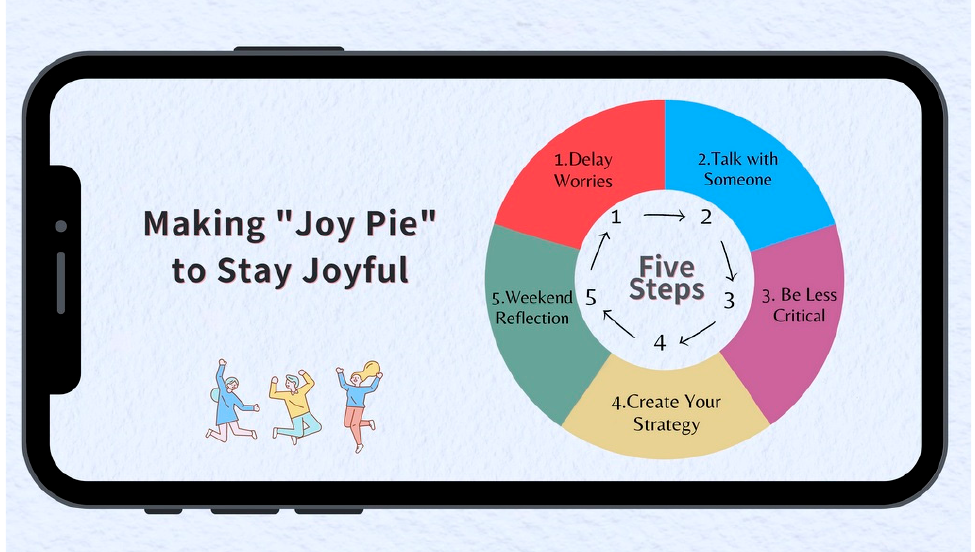
Figure 1. The “Joy Pie” interventions for mental health management (Illustration by Lola Xie)